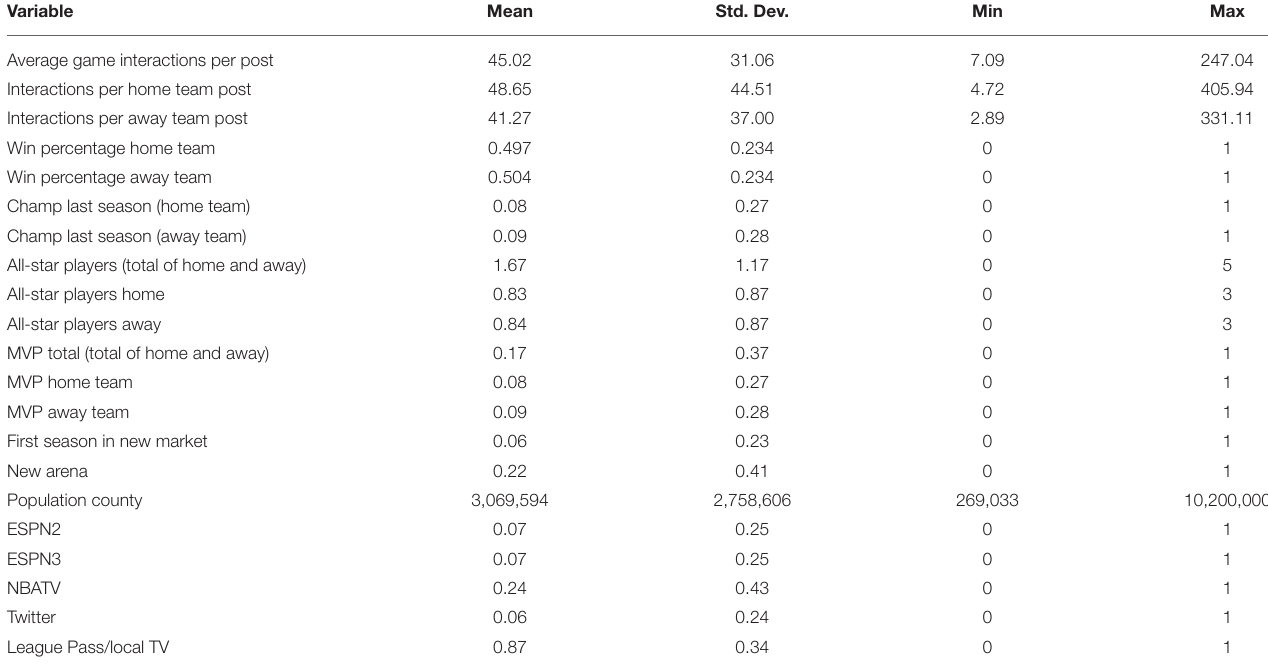
TABLE 1 | Descriptive